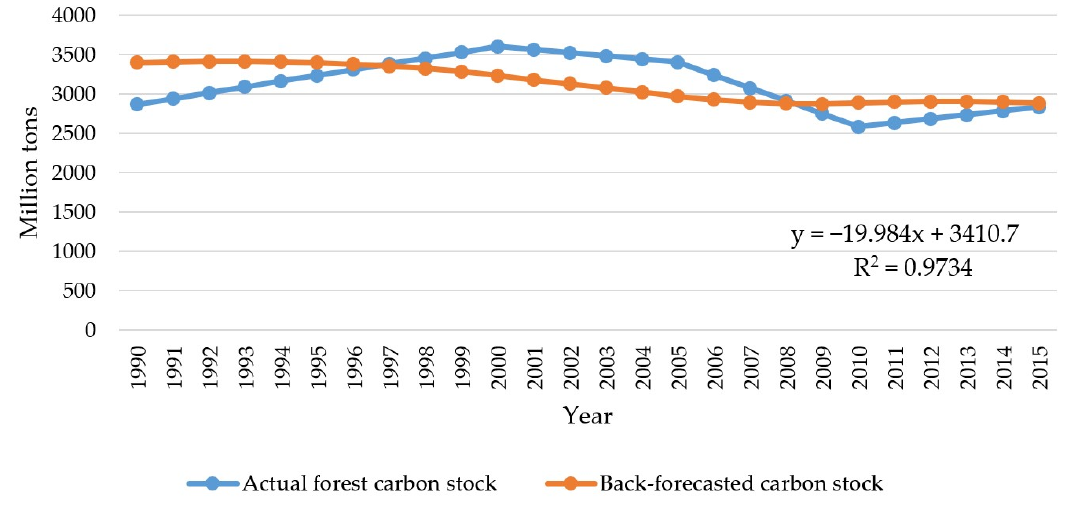
Figure 6. Comparison between the actual data on forest carbon stock and the back-forecasted carbon stock.